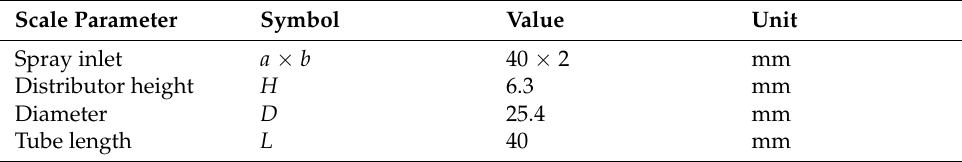
Figure 1. Schematic diagram of calculation domain. Table 1. Scale parameters of the